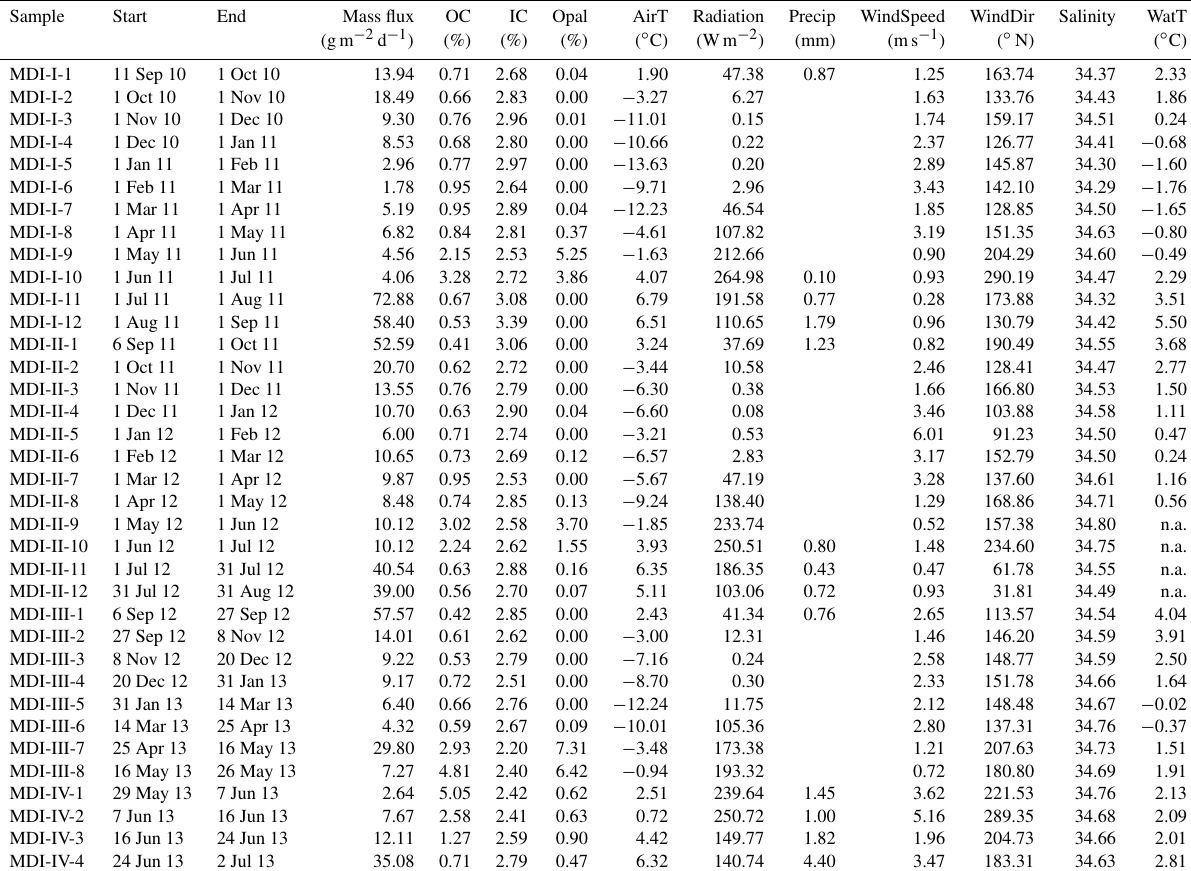
Table A1. Sediment trap data set, with meteorological and hydrological data. Physical data were averaged according to the sampling periods.